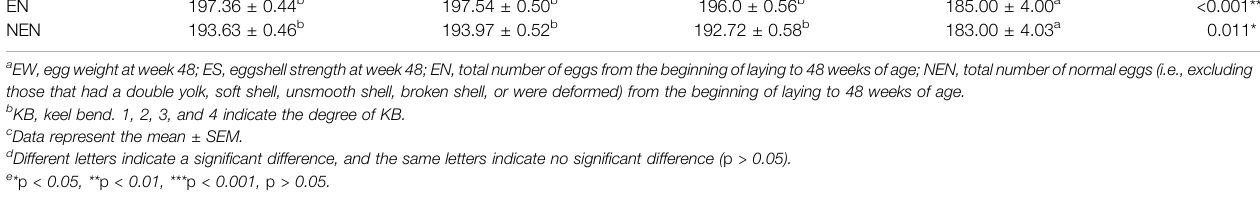
Frontiers in Genetics |